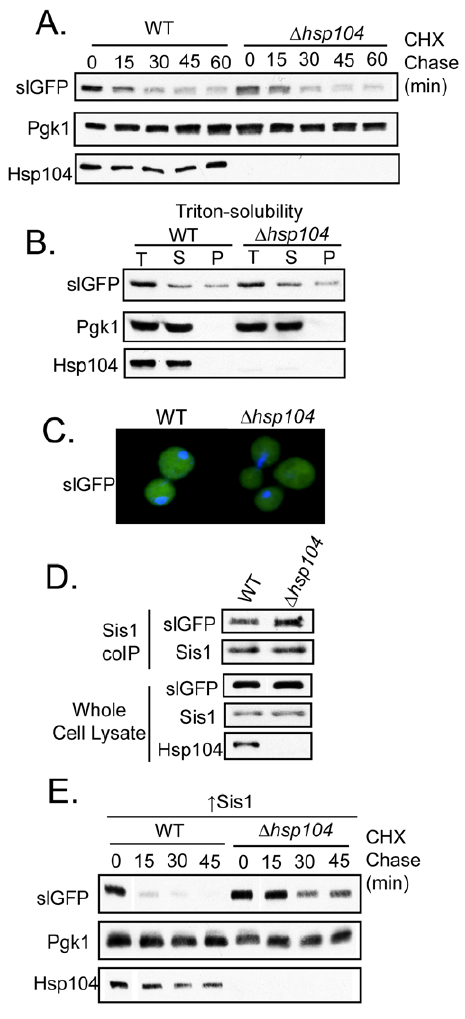
Figure 7. Hsp104 Is Required For Sis1 To Accelerate SlGFP Degradation. A) Cycloheximide-chase analysis of slGFP turnover in WT or D hsp104 . B) Triton X-100-solubility of slGFP (T-total, S-supernatant, P- pellet). C) Fluorescence microscopy of slGFP localization D) Co- immunoprecipitation Sis1 and slGFP from a WT or D hsp104 strain (upper panel). Total protein levels are shown in the lower panel. E) Cycloheximide-chase analysis of slGFP turnover in a WT or D hsp104 strain with overexpressed